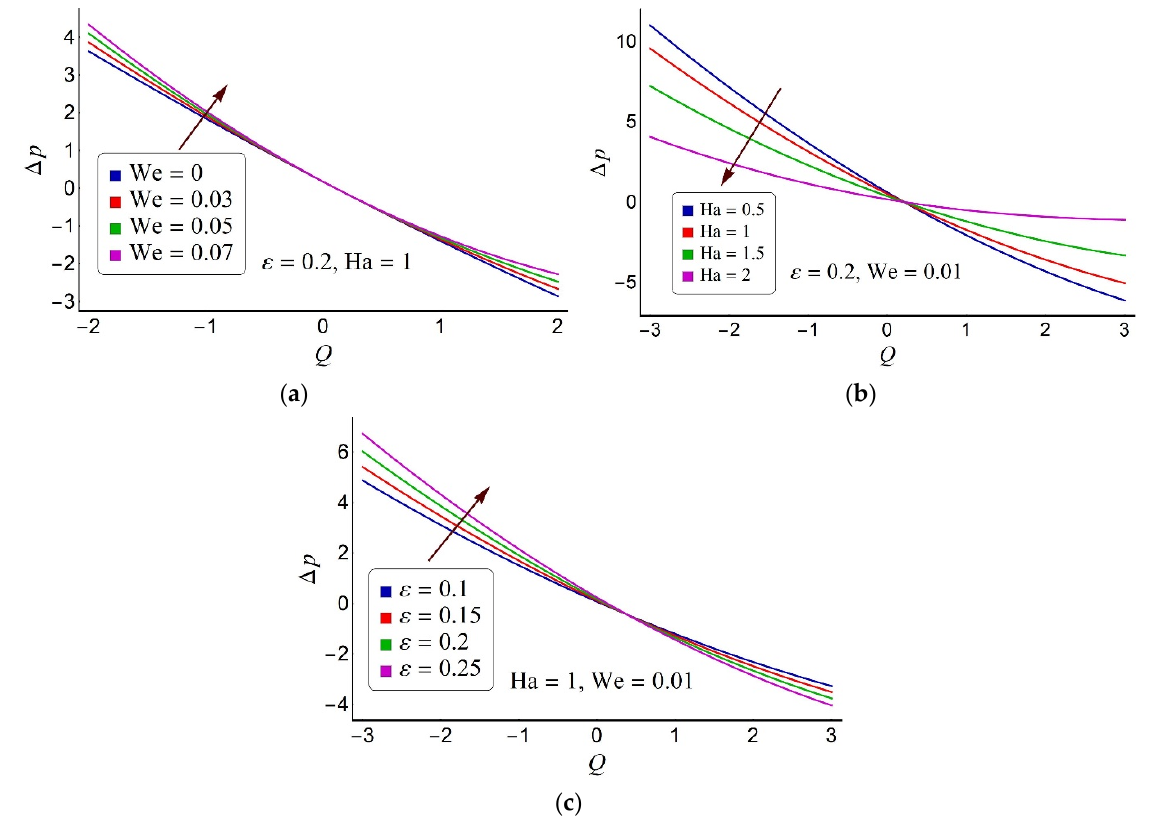
Figure 4. Alterations in pressure rise per metachronal wavelength for distinct values of ( a ) Weissenberg number (We), ( b ) Hartmann number (Ha), and ( c ) cilia length parameter ( ε ).